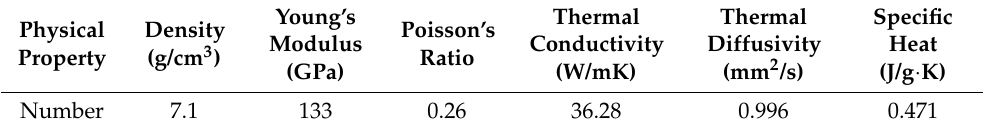
Table 3. Physical properties of CGI.